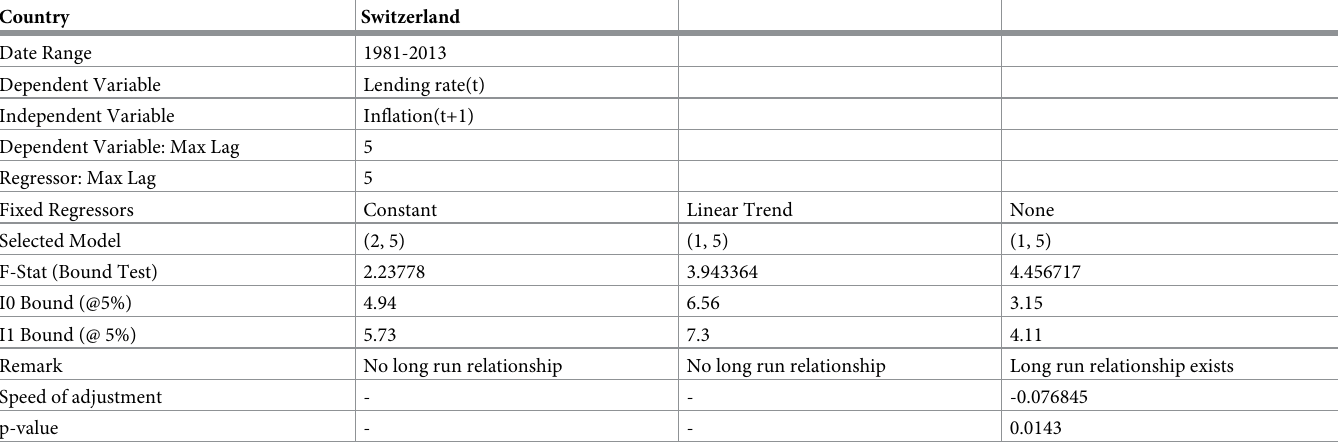
Table 28. ARDL Bounds Testing for Swiss data under Fisherian